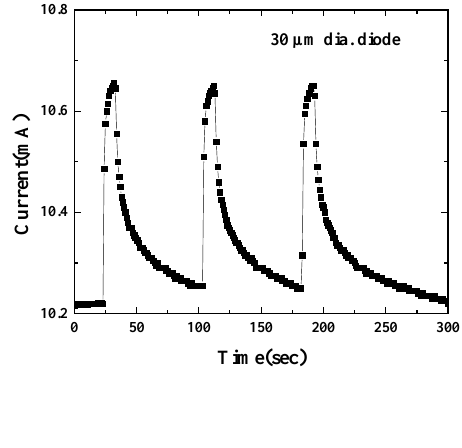
to 10%H /90%N for periods of 10, 20 or 30 secs and then back 2 2 2